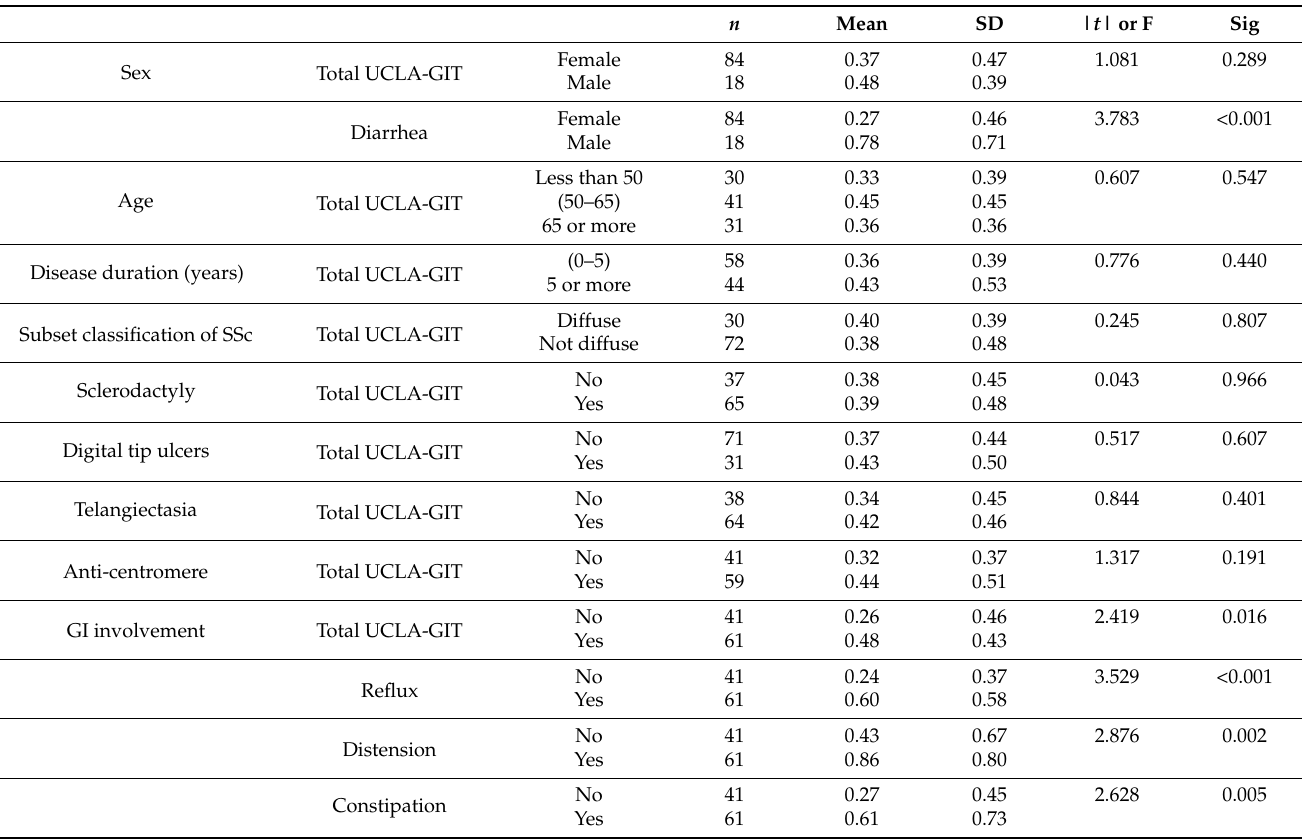
Table 6. Total UCLA GIT scores for different levels of sociodemographic and clinical variables.